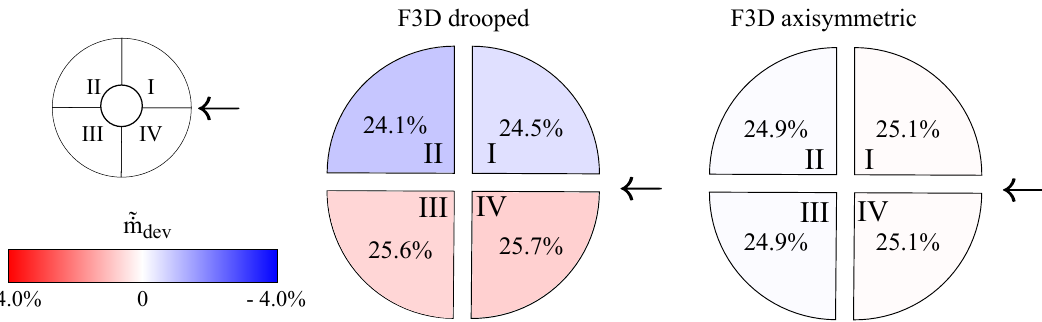
Figure 7. Distribution of mass flow at fan face quadrants for F3D drooped and axisymmetric viscous simulations, when (cid:101) ˙ m = 1 (pie colours represent ˙ m dev